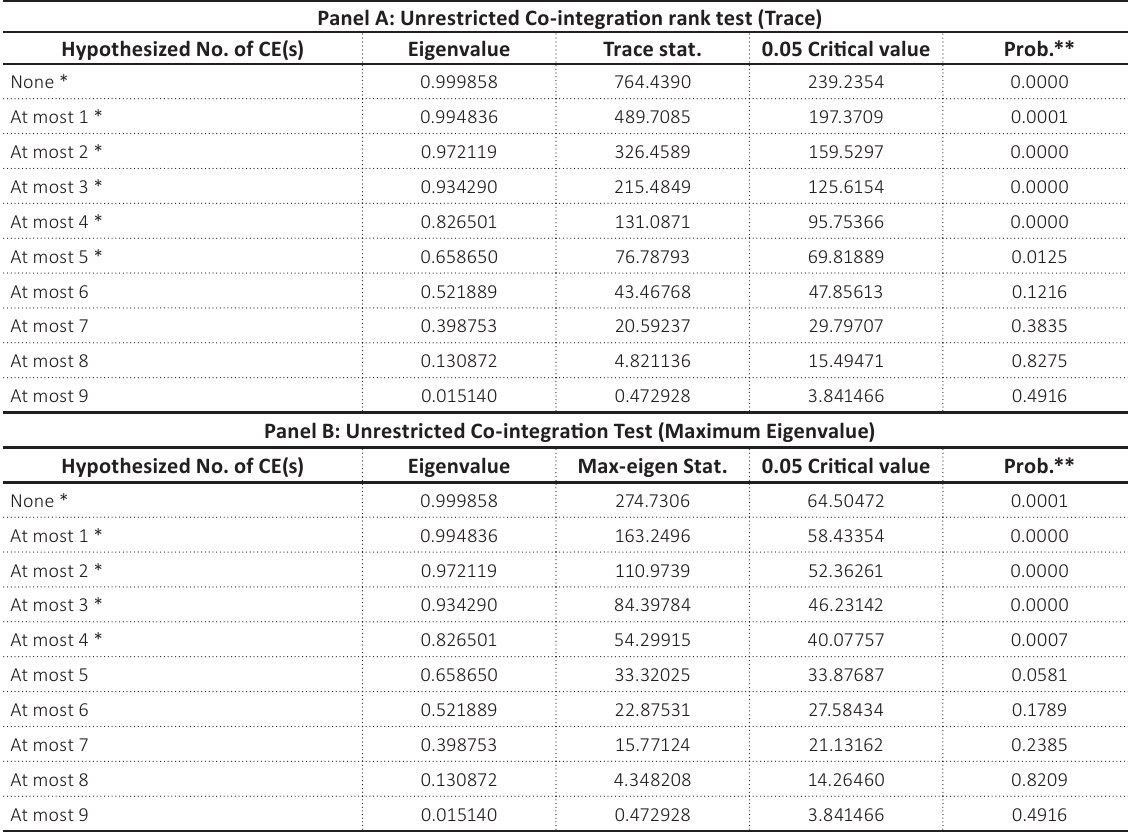
Table 3. The results of Johansen’s co-integration